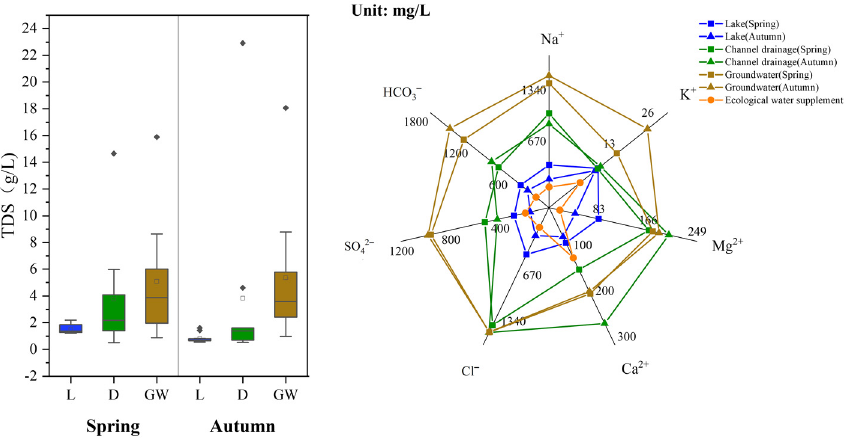
Figure 10. Changes in hydrochemical characteristics of the three water bodies in different seasons in 2021.